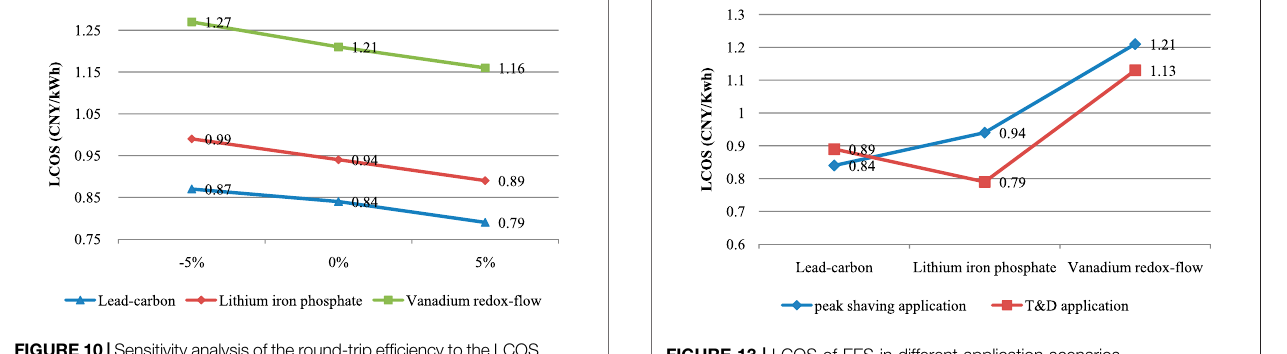
FIGURE 13 | LCOS of EES in different application